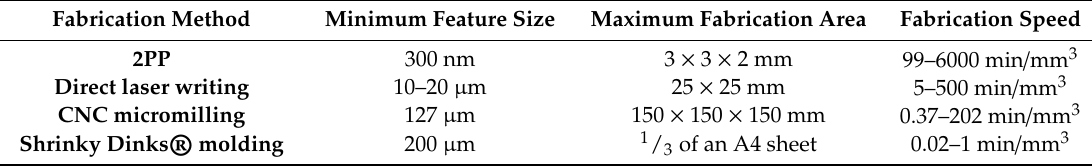
Table 1. Comparison of the resolution, area and speed of the di ff erent fabrication methods used in this work. The reported fabrication speed is calculated with the di ff erent fabrication parameters used for each